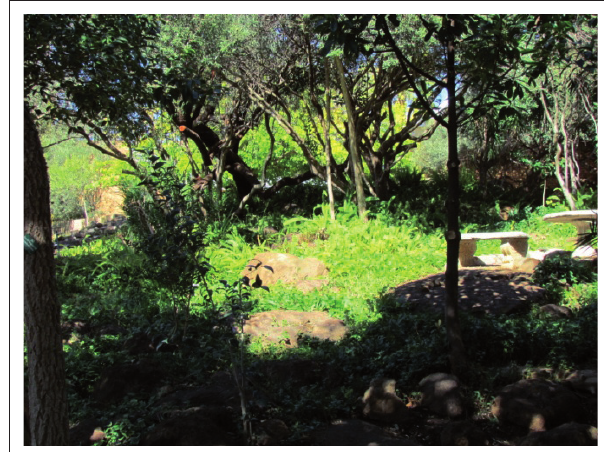
FIGUUR 11: ‘Elke klip was iemand se bed.